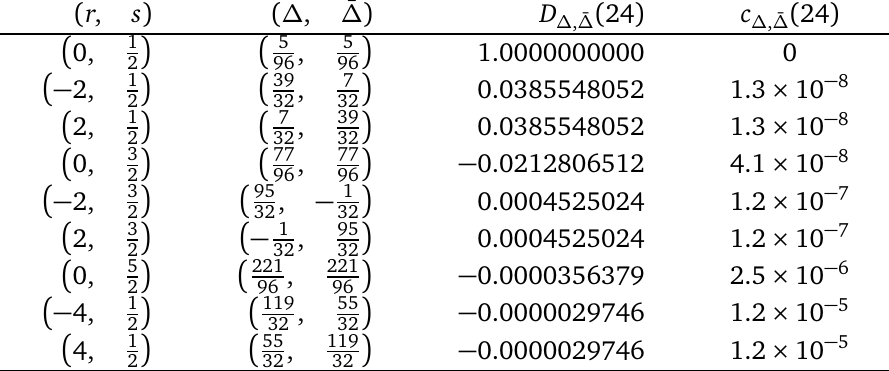
Table 4: The first 9 states in the spectrum (cid:83) at c = 0, together with the values of their 2 (cid:90) , (cid:90) + 1 2 conformal dimensions, of their structure constants, and of the coefficients of variation when the spectrum is truncated to N = 24 states. The coefficient of variation gives a rough estimate of the precision of our determination of the corresponding structure